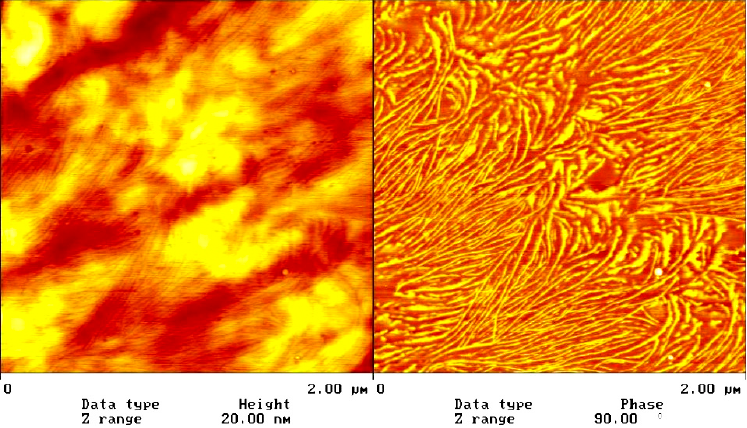
Figure 8. AFM height ( left ) and phase image ( right ) of the surface of a part of PHBHHx banded spherulite completely crystallized at 45 °C. Adapted with permission from Ref. [27]. Copyright (2004) American Chemical Society.